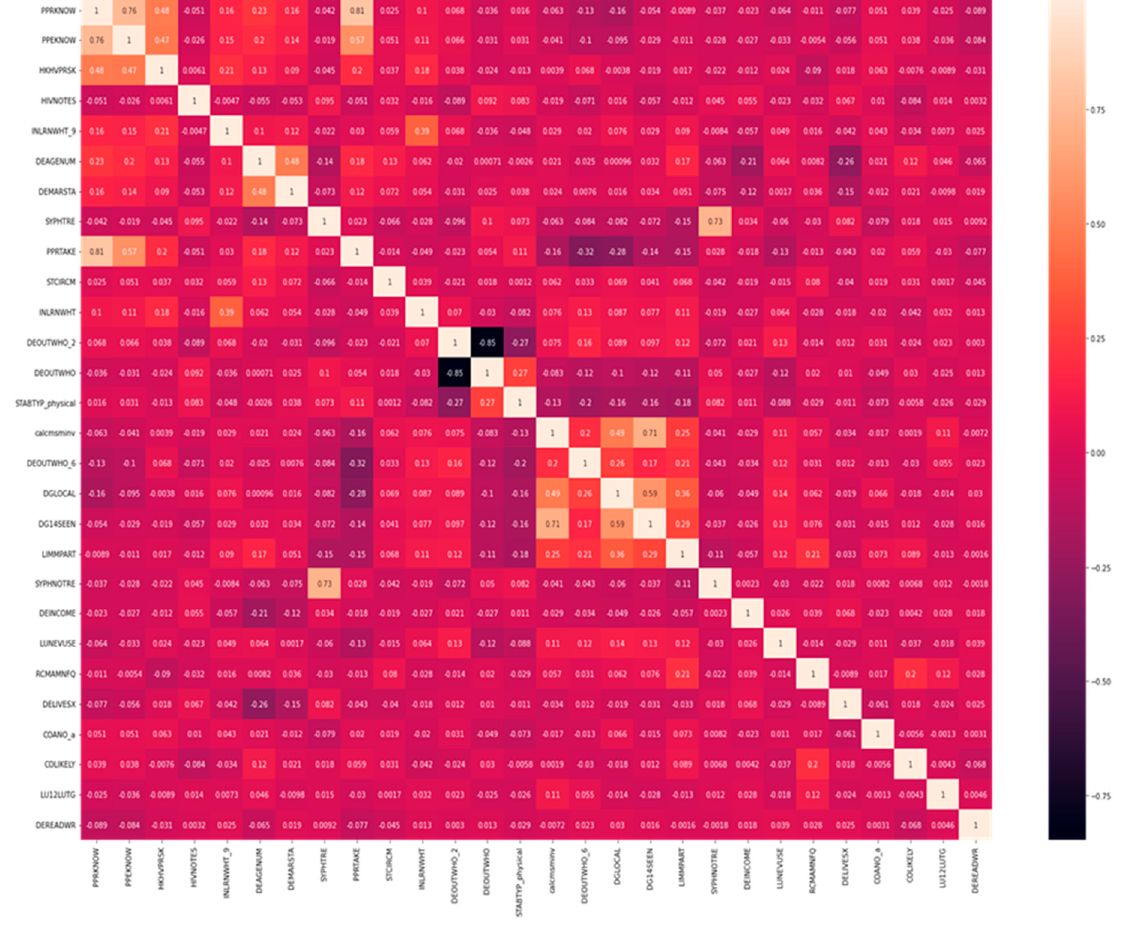
Figure 1. Correlation matrix of the selected